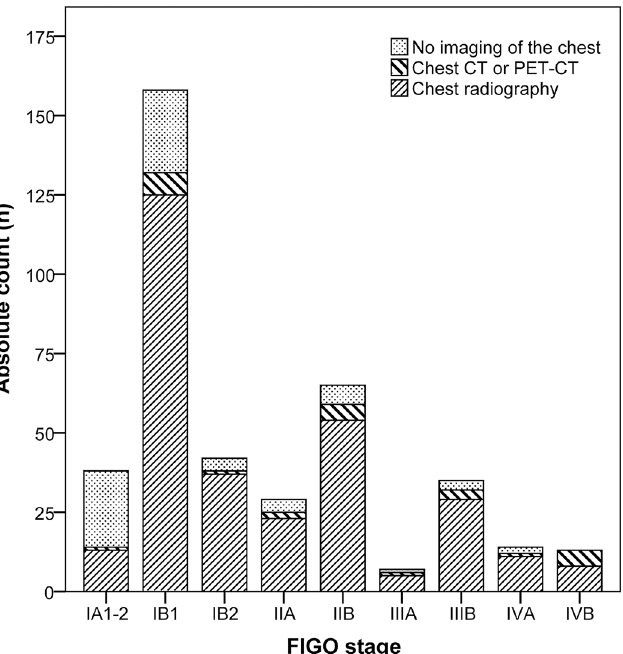
Fig 2. Stacked bar graph of the primary thoracic imaging examinations performed during the staging of all eligible patients (n = 402). CT: Computed Tomography; PET: Positron Emission Tomography; FIGO: International Federation for Gynecology and